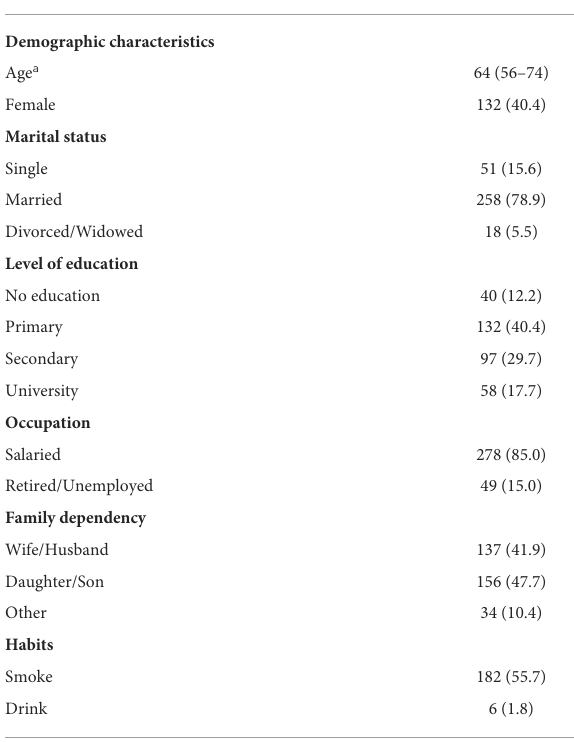
TABLE 1 Baseline and demographic characteristics of the study participants ( N = 327).